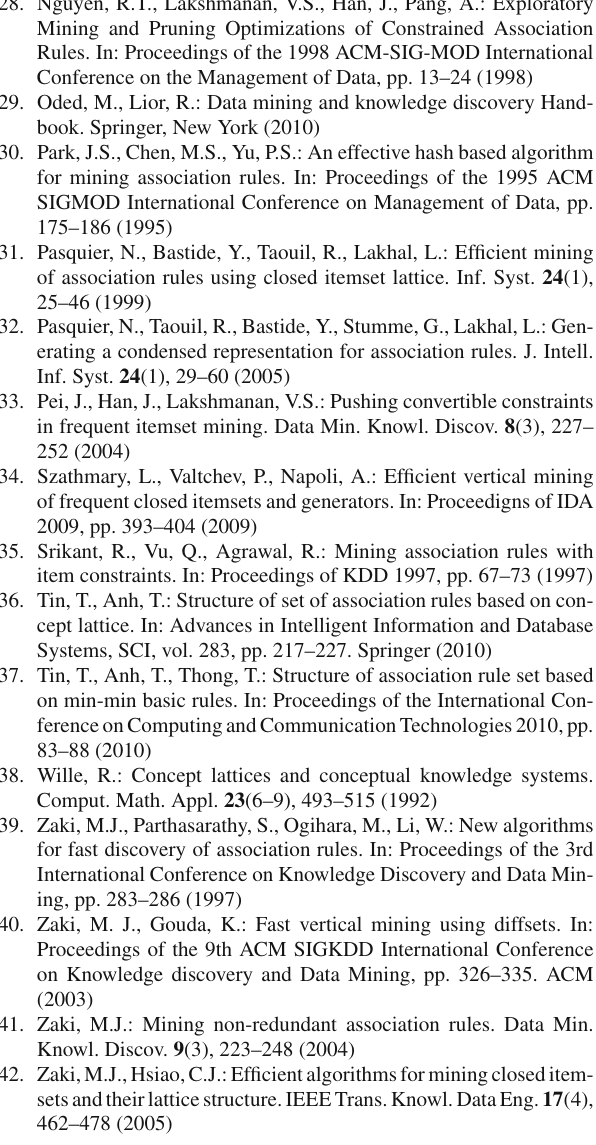
setsandtheirlatticestructure.IEEETrans.Knowl.DataEng. 17 (4), 462–478